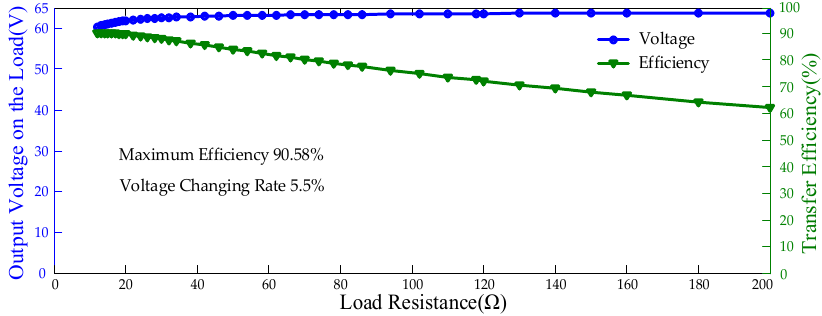
Figure 6. Output voltage and efficiency respectively versus load resistance for the 3-coil system.